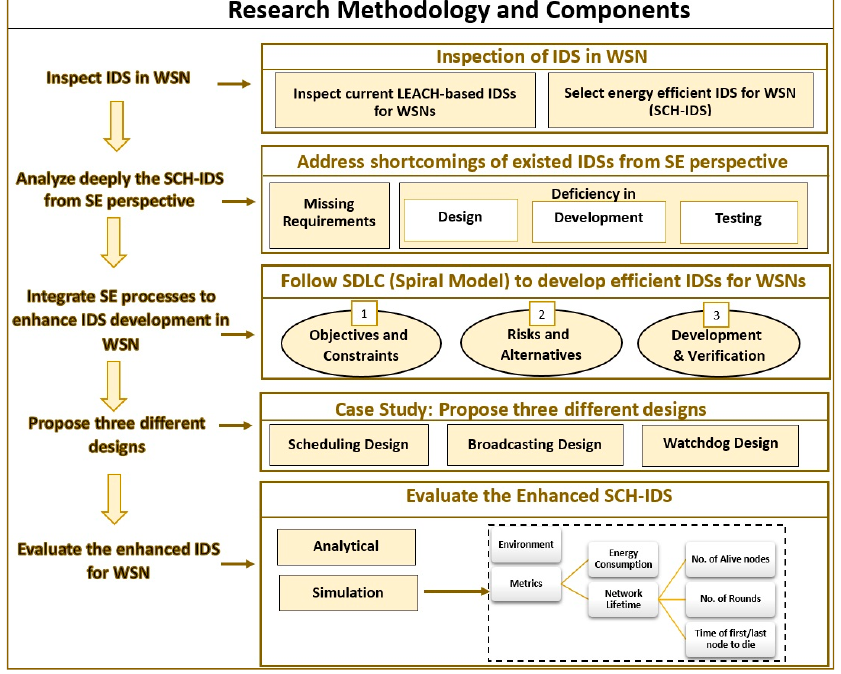
Figure 2. Research methodology and